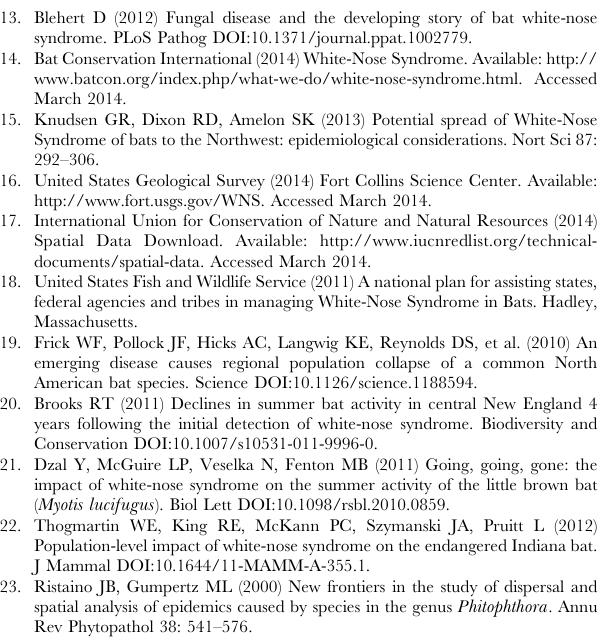
Figure S2 The geographic distribution of hibernating bat species richness in North America. (TIF) Table S1 Geographic coordinates for sites with the fungus Pseudogymnoascus destructans. For North Amer- ican sites, we used the central points of the counties where the disease has been confirmed (compiled from [18]; March 2014). European sites were compiled from